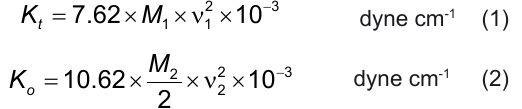
and K ) and bond length (R O t